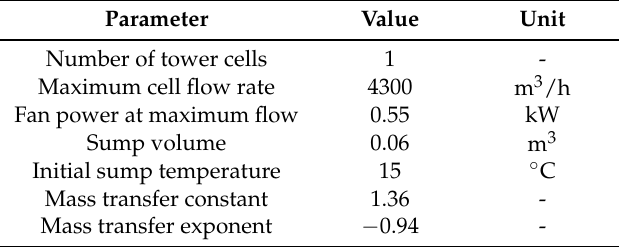
Table 8. Cooling tower (CT)